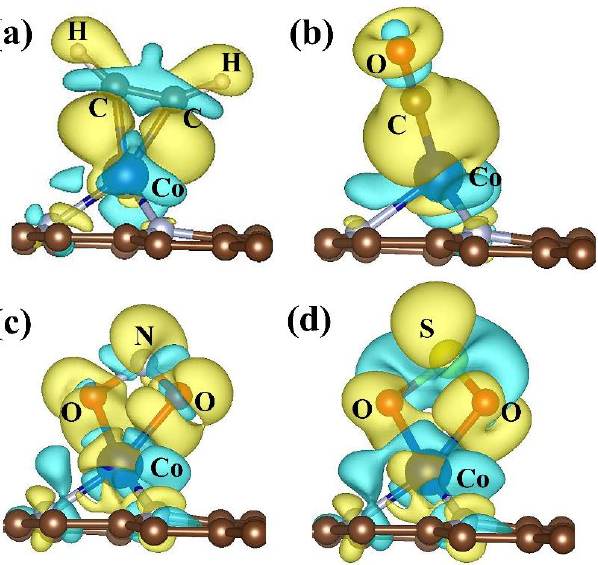
Figure 2. The charge density difference of Co/N 3 – gra with ( a ) C 2 H 2 , ( b ) CO, ( c ) NO 2 , and ( d ) SO 2 adsorbed on it. The yellow and blue areas indicate the accumulation and depletion of charge, respectively. Isosurface value: 0.002 e/Bohr 3 .